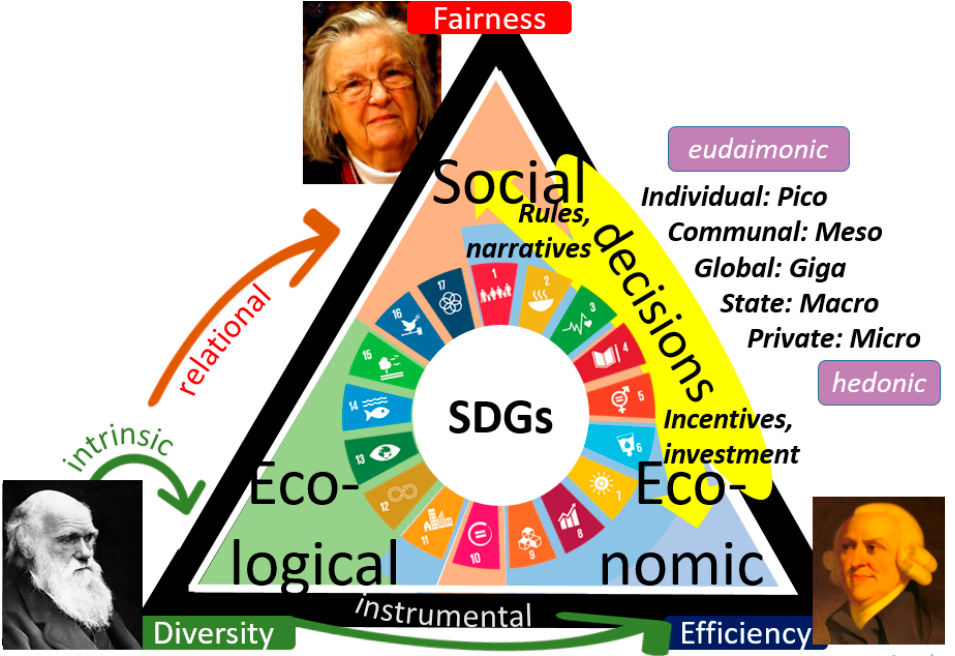
Figure 2. The triple bottom line of People–Profit–Planet or social, economic, and ecological aspects of value (importance, exchangeability, and long-term survival) for sustainability is reflected in the current set of 17 Sustainable Development Goals (SDGs) and connects the intellectual breakthroughs of the invisible hand, blind watchmakers, and not-so-tragic commons, attributed to Adam Smith [18]., Charles Darwin [19], and Elinor Ostrom [20], respectively; human decision making across the social–economic spectrum depends on the scale (see Figure 3 for the pico–giga terminology) and reflects different types of values: the intrinsic, instrumental, and relational values of nature and its diversity, the efficiency of using scarce resources, and the hedonic and eudaimonic improvements of human quality of life (see below for a further discussion).